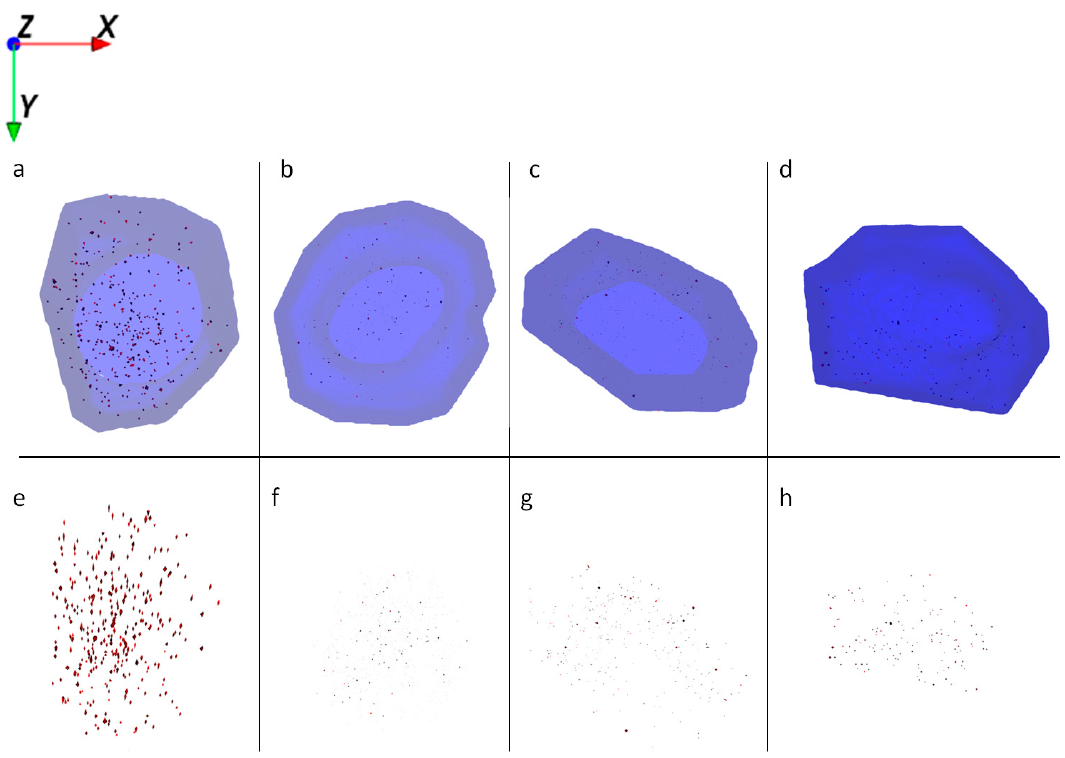
Figure 5. Ion reconstruction of a 3D depth profile (depth layer numbers: 50–250) of one single HaCaT cell exposed to Al 2 O 3 NMs for 24 h. The images show the top-down view of the outline of a cell of a depth profile. The translucent blue outline was reconstructed based on the C 3 H 8 N + signal that originates from intracellular amino acids. ( a ) Control cells exposed to Al 2 O 3 NMs only (red color); and corresponding intracellular localization of Al 2 O 3 NM agglomerates ( e ). ( b ) Cells treated with retinol and Al 2 O 3 NMs (red); and corresponding intracellular localization of Al 2 O 3 NM agglomerates ( f ). ( c ) Cells treated with low vitamin D3 and Al 2 O 3 NMs (red); and corresponding intracellular localization of Al 2 O 3 NM agglomerates ( g ). ( d ) Cells treated with high vitamin D3 and Al 2 O 3 NMs (red); and corresponding intracellular localization of Al 2 O 3 NM agglomerates ( h ).